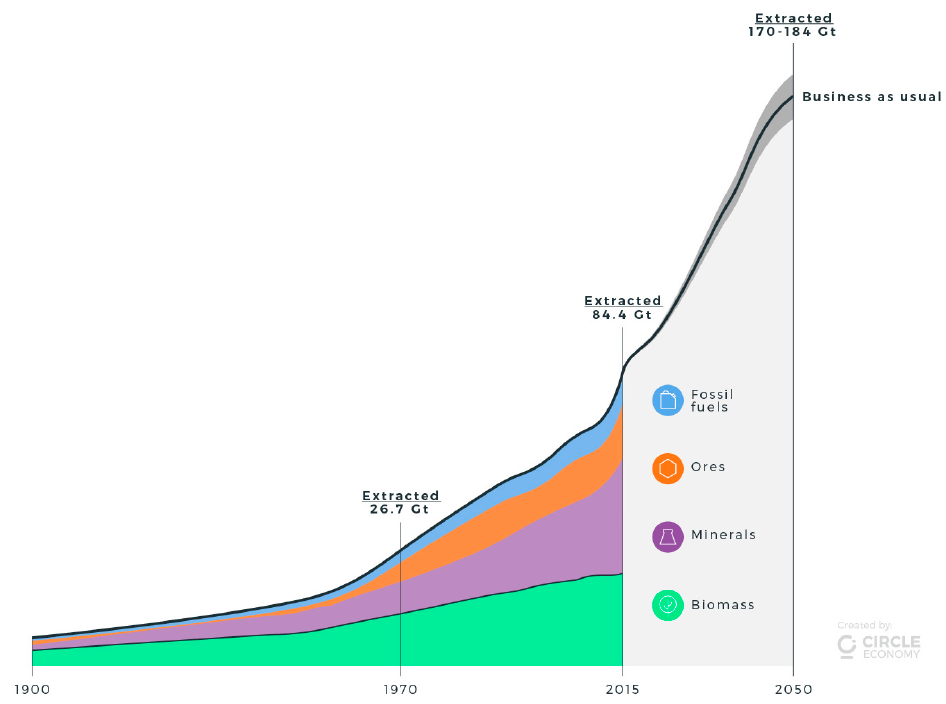
Figure 5. Worldwide increase in raw material extraction (according to de Wit et al. [104]); Biomass, Minerals, Ores, Fossil Fuels; graphic: Kay van ’t Hof, Circle